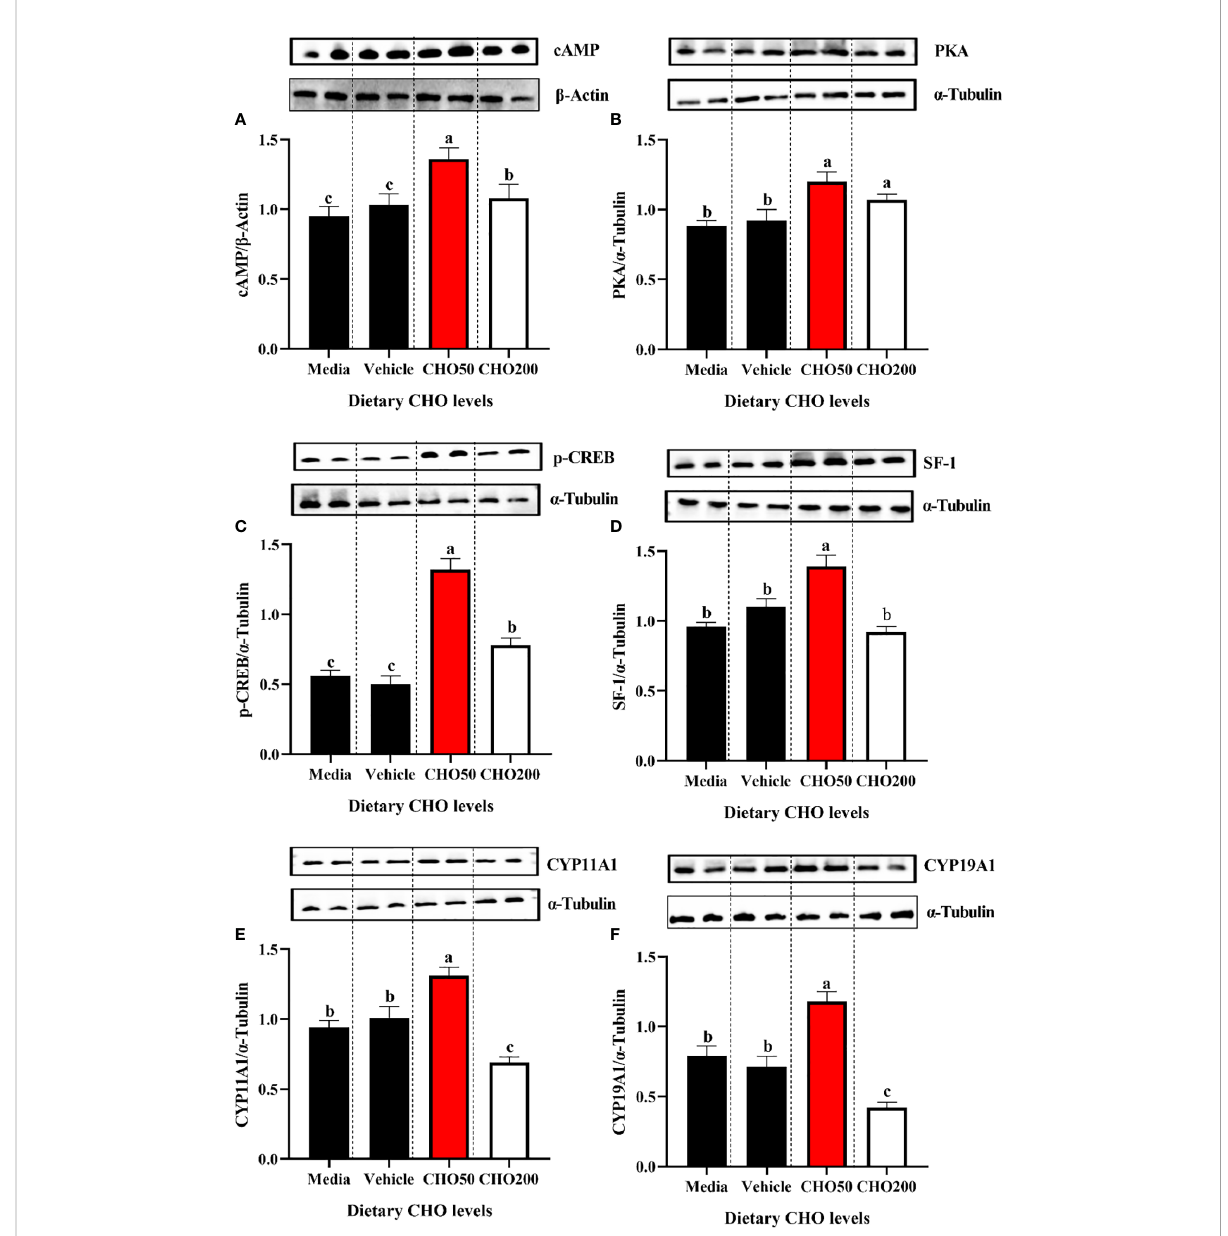
FIGURE 7 The protein expression of (A) cAMP; (B) PKA, (C) p-CREB, (D) SF-1, (E) CYP11A1 and (F) CYP19A1 in the ovary exposed to 0, 50 and 200 mg/L CHO. The values are the Means ± SEM (n = 4). Different letters indicate signi fi cant differences ( P <